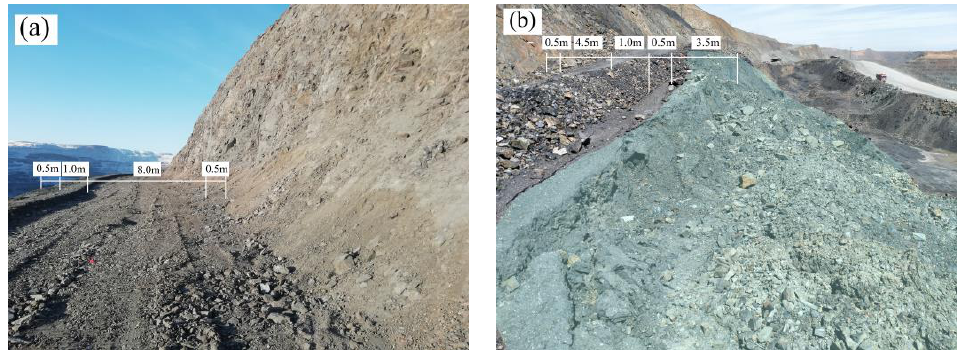
Figure 5. Site collapse comparison: ( a ) Normal bench; ( b ) Post-collapse bench.